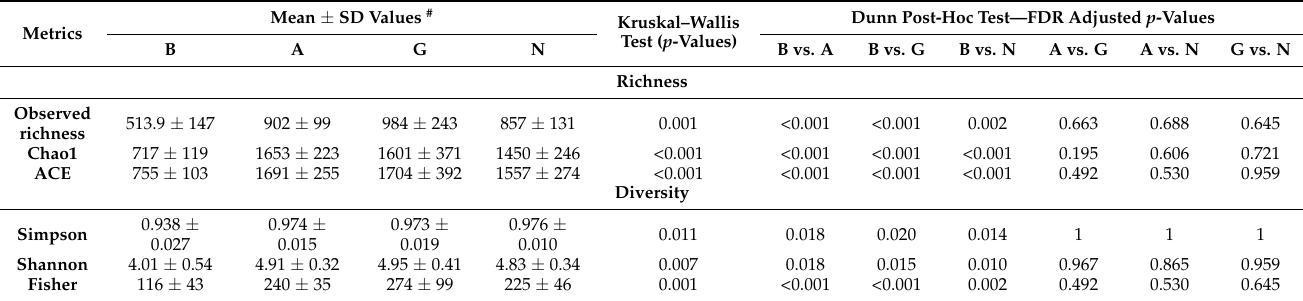
Figure 1. Alpha diversity across samples. Sequences were rarified to the minimum library size (at 12,151 sequences per sample). Differences in alpha diversity metrics of microbial diversity and richness in the gut microbiota of chickens of different breeds or lines are shown as boxplots. ( a ) the observed number of OTUs, ( b ) Chao1, ( c ) abundance based coverage estimator (ACE), ( d ) Shannon, ( e ), Simpson, ( f ) Fisher. Table 2. Statistical analysis of alpha diversity measures for comparing different breeds or line. p -values were adjusted for false discovery rate